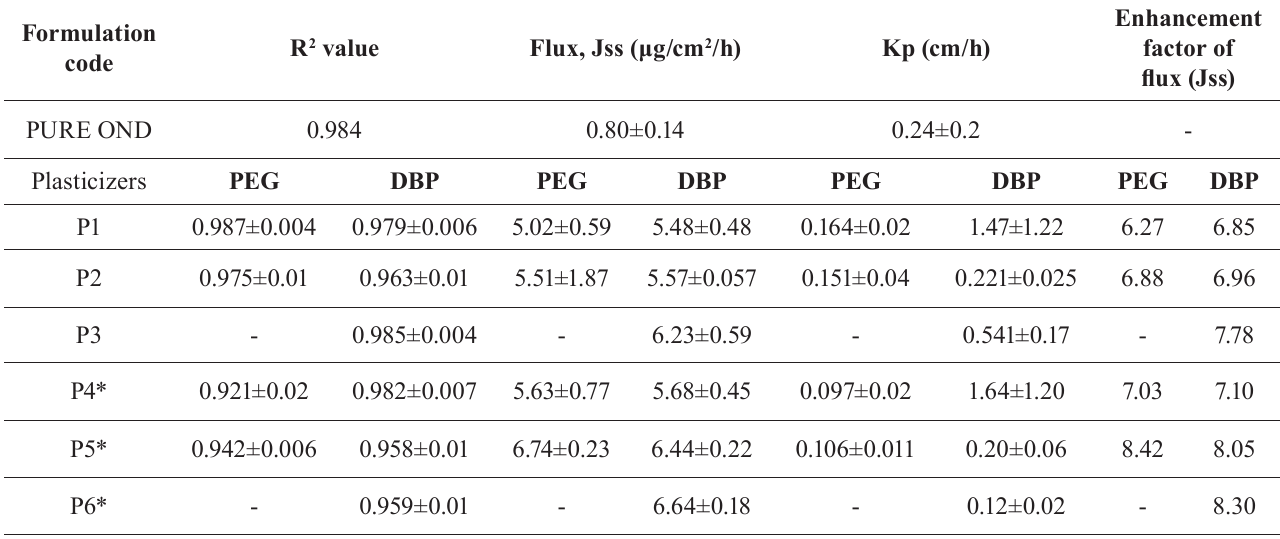
R 2 = Rrgression coefficient according to zero order kinetics, Kp= permeation